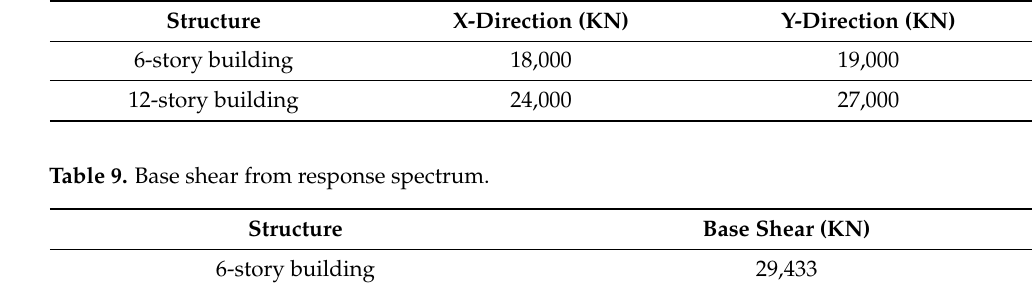
Table 8. Base shear obtained from the response spectrum analysis (X and Y directions).